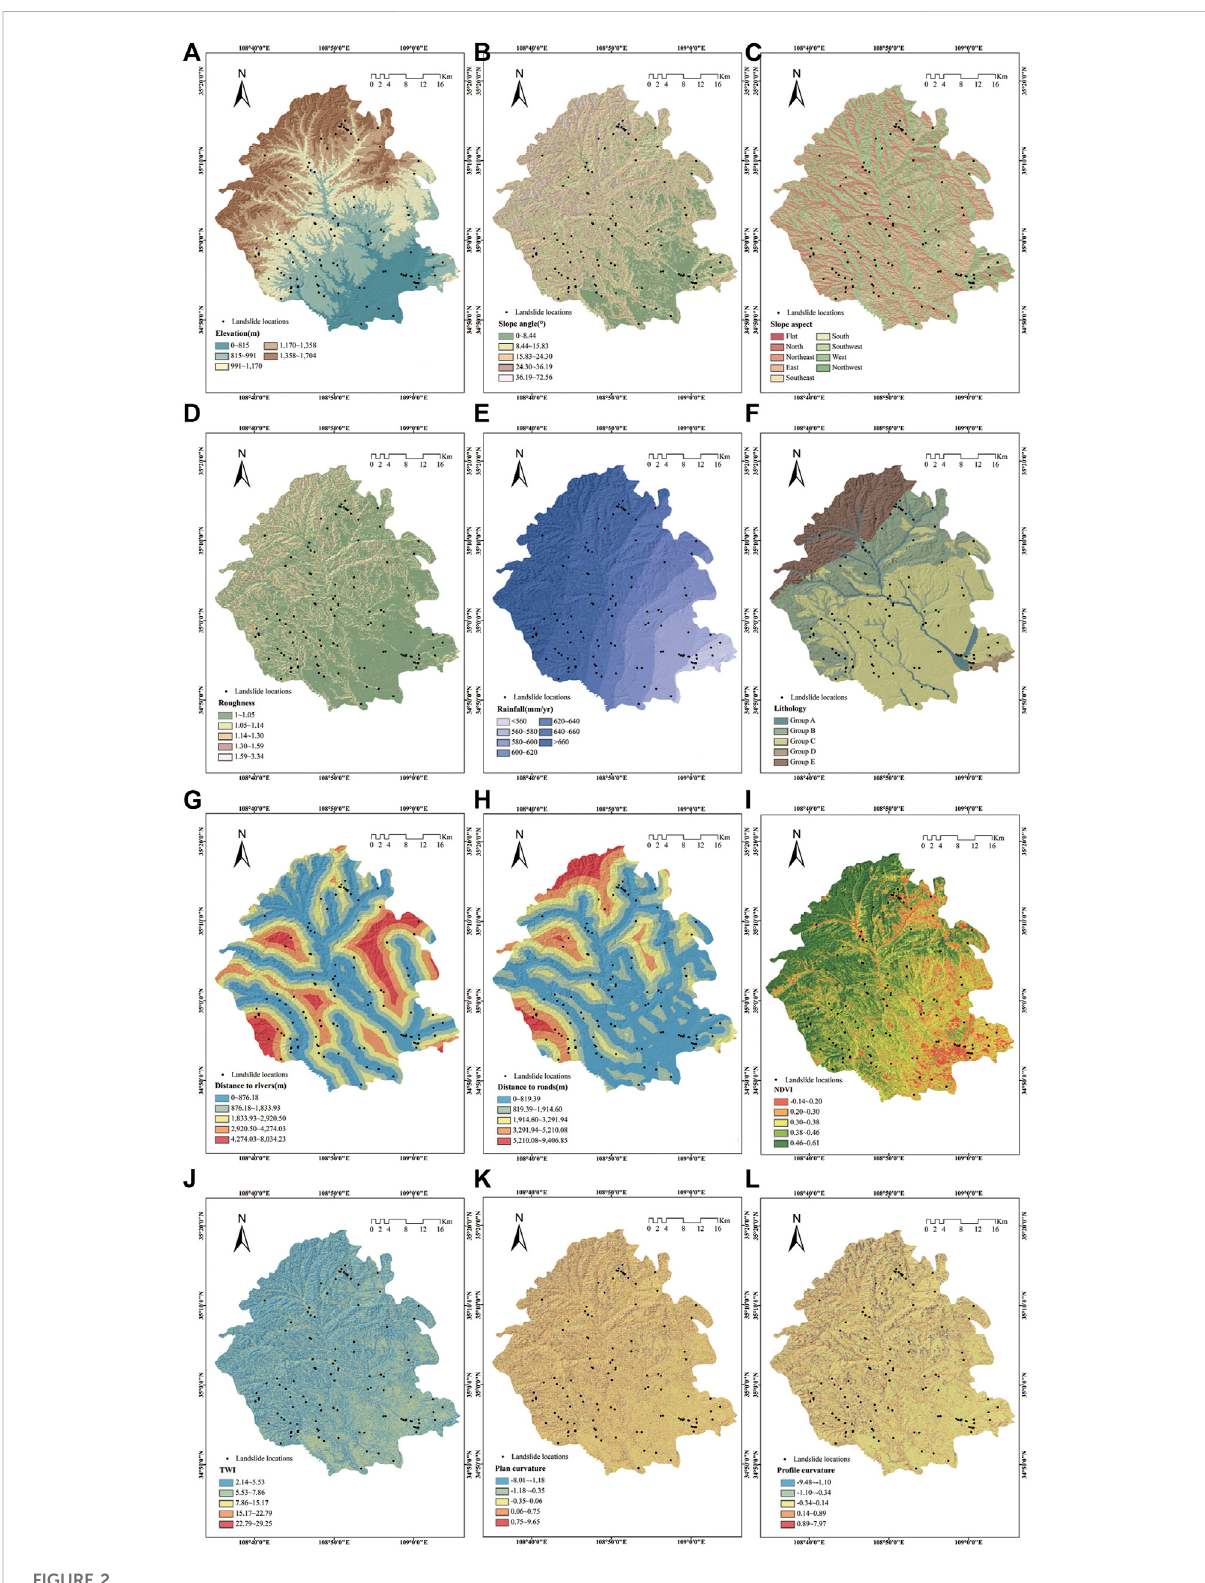
FIGURE 2 Thematic maps of the study area: (A) elevation; (B) slope angle; (C) slope aspect; (D) roughness; (E) rainfall; (F) lithology; (G) distance to rivers; (H) distance to roads; (I) NDVI; (J) TWI; (K) plan curvature; (L) pro fi le